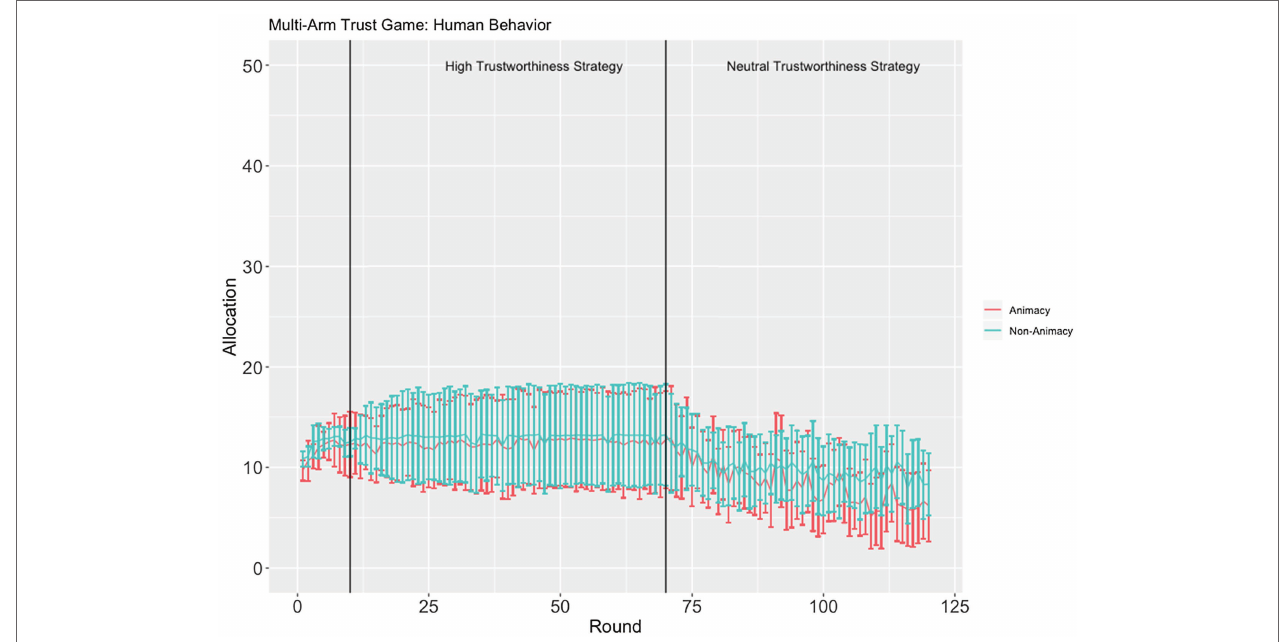
FIGURE 3 | The average ±95% CI allocation across all three confederate agents in the animacy (red) and inanimacy (blue)